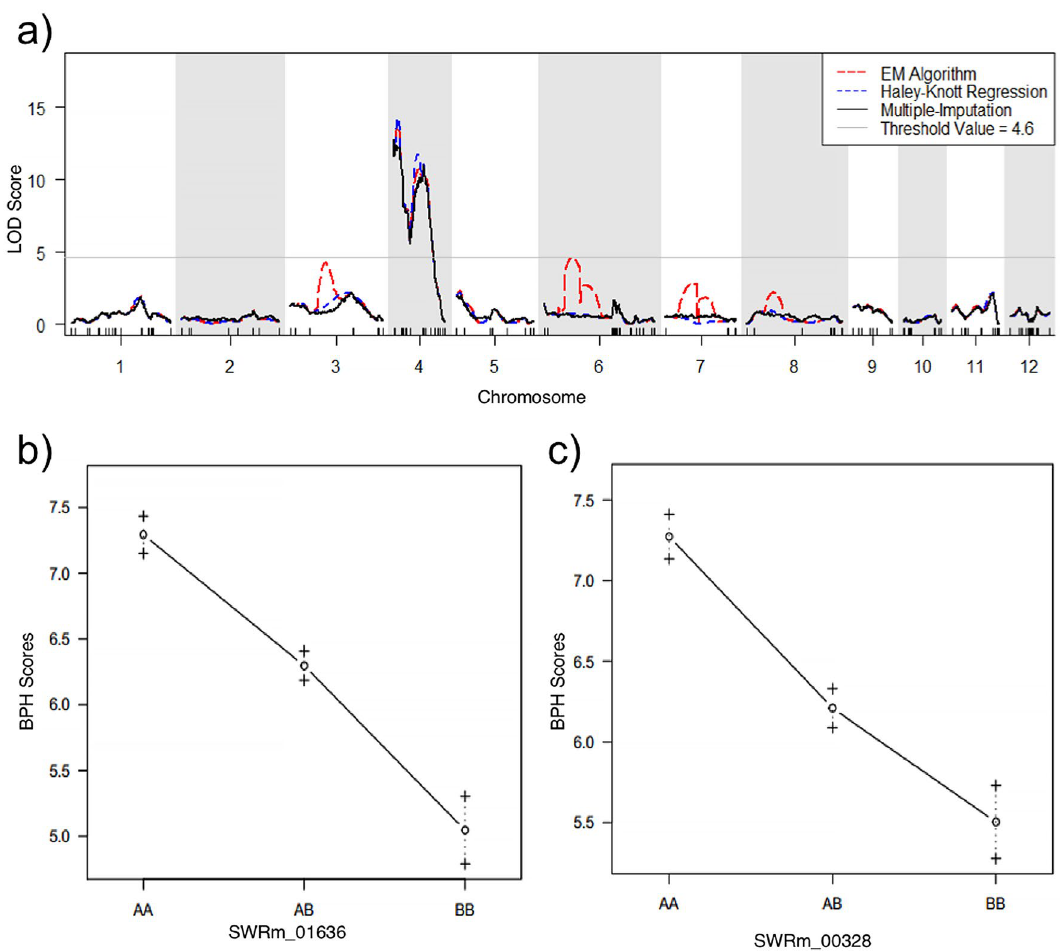
Figure 1. QTL mapping and effect plots of SWR66 × SWD10 F 2 mapping population. ( a ) QTL mapping results of F 2 mapping population. Results of three algorithms used are indicated with red (EM algorithm), blue (Haley Knott Regression) and black (multiple imputation) lines. The grey line indicates the LOD threshold value of 4.6 detected by performing a 1000 permutation test using the EM algorithm. The LOD threshold values detected by 1000 permutation tests for the HK algorithm and multiple imputation are 4.34 and 4.19, respectively. Two major QTLs are identified on chromosome 4. The highest peak is designated as BPH41 (LOD = 12.30), and the second peak is designated as BPH42 (LOD = 11.08). ( b , c ) Effect plots of markers SWRm_01636 and SWRm_00328. These markers are located closest to the peak for BPH41 and BPH42, respectively. AA, AB and BB represent homozygous susceptible, heterozygous and homozygous resistant genotype, respectively. The BPH